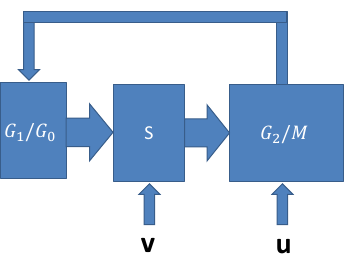
Fig. 5 A 3-compartment model with cytostatic agent v and cytotoxic agent u